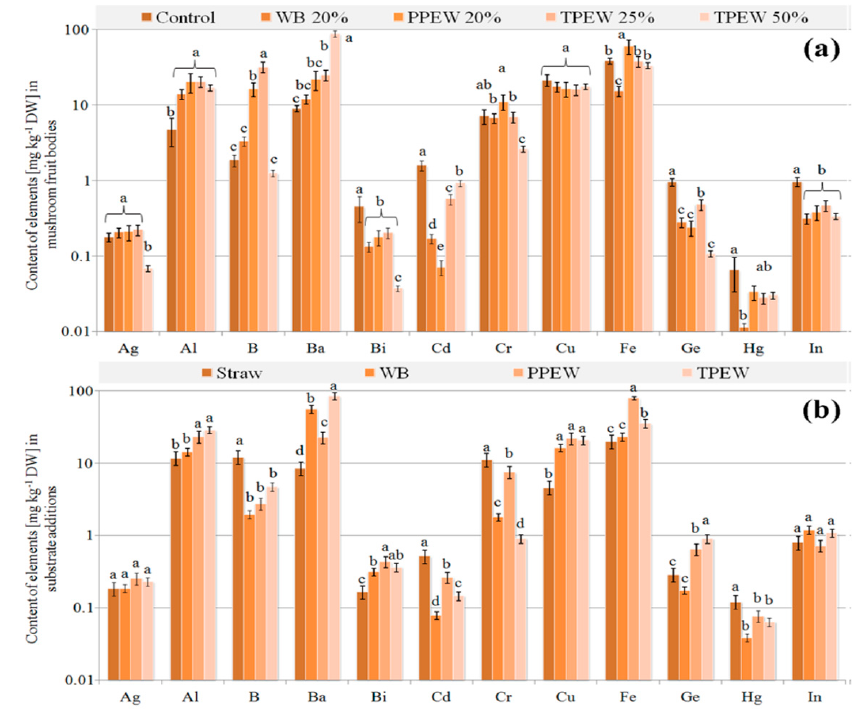
Figure 3. Content of trace elements (mg kg − 1 DM) in Pleurotus citrinopileatus fruit bodies ( a ) and particular additions included to substrate ( b ). Mean values ( n = 3); identical superscripts ( a–d ) denote no significant ( p < 0.05) difference between mean values in columns according to Tukey’s HSD test (ANOVA) for mushrooms growing at particular substrates. WB—wheat bran, PPEW—pumpkin post-extraction waste, TPEW—thymus post-extraction